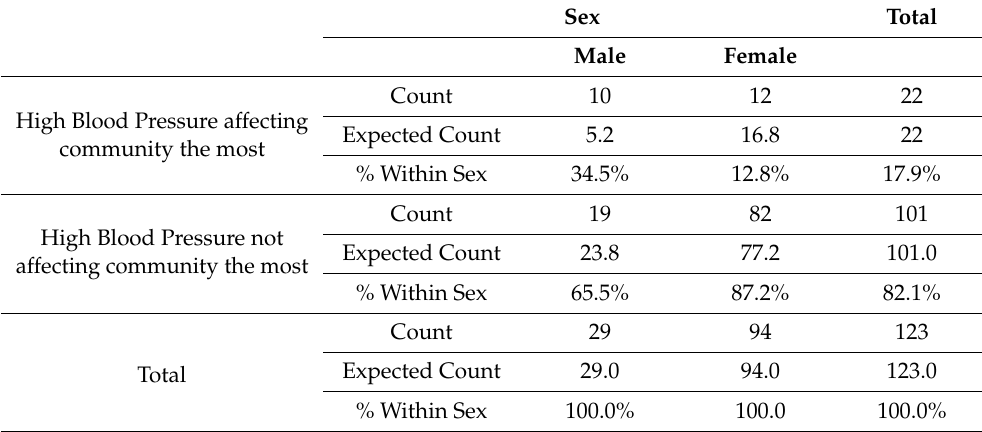
Sex Total Male Female Count Expected Count % Within Sex